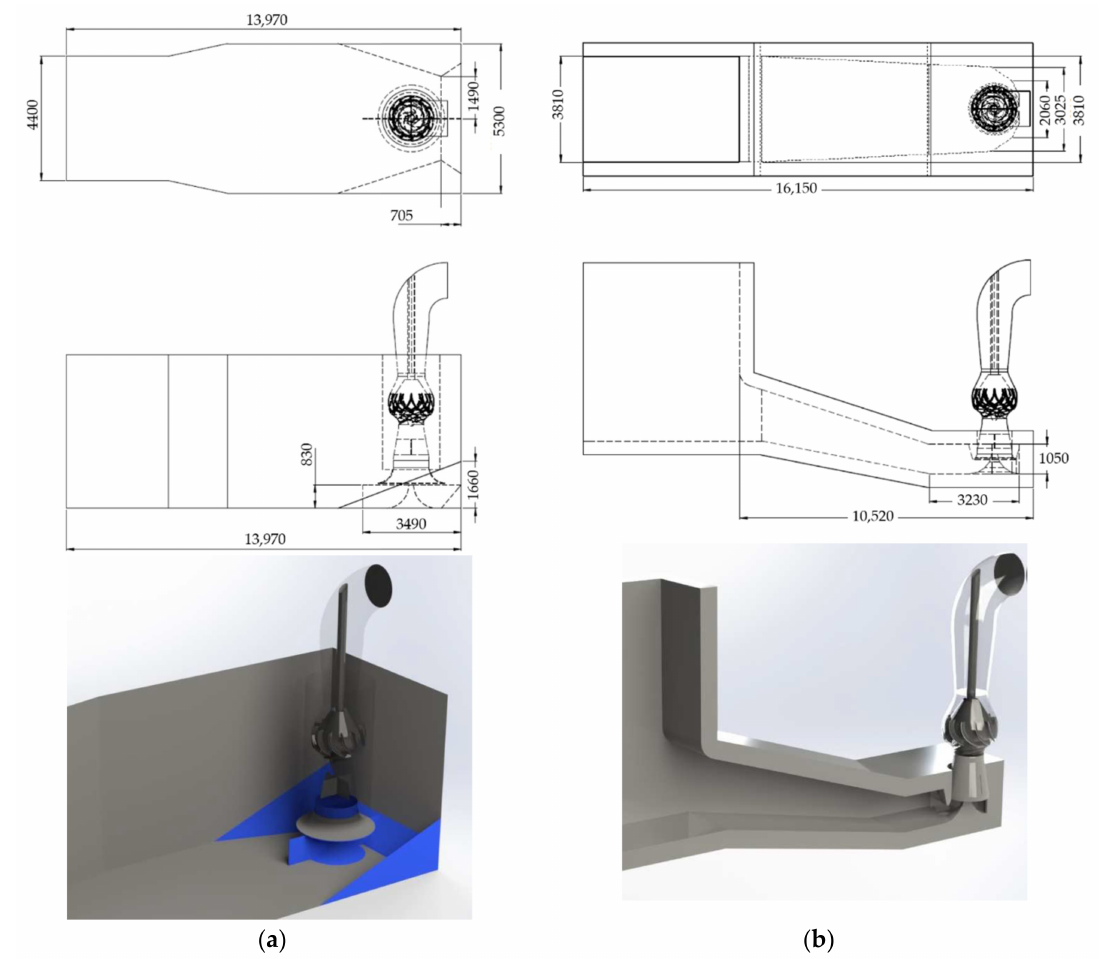
Figure 12. ( a ) A variation of the pump sump based on Ingersoll-Rand (1991) recommendation using a floor cone instead of a floor splitter (Case 3), ( b ) A variation of a forced suction intake (FSI) model pump sump based on the “TYPE 10” FSI design developed by the US Army Corps of Engineers (ETL No. 1110-2-327) (Case